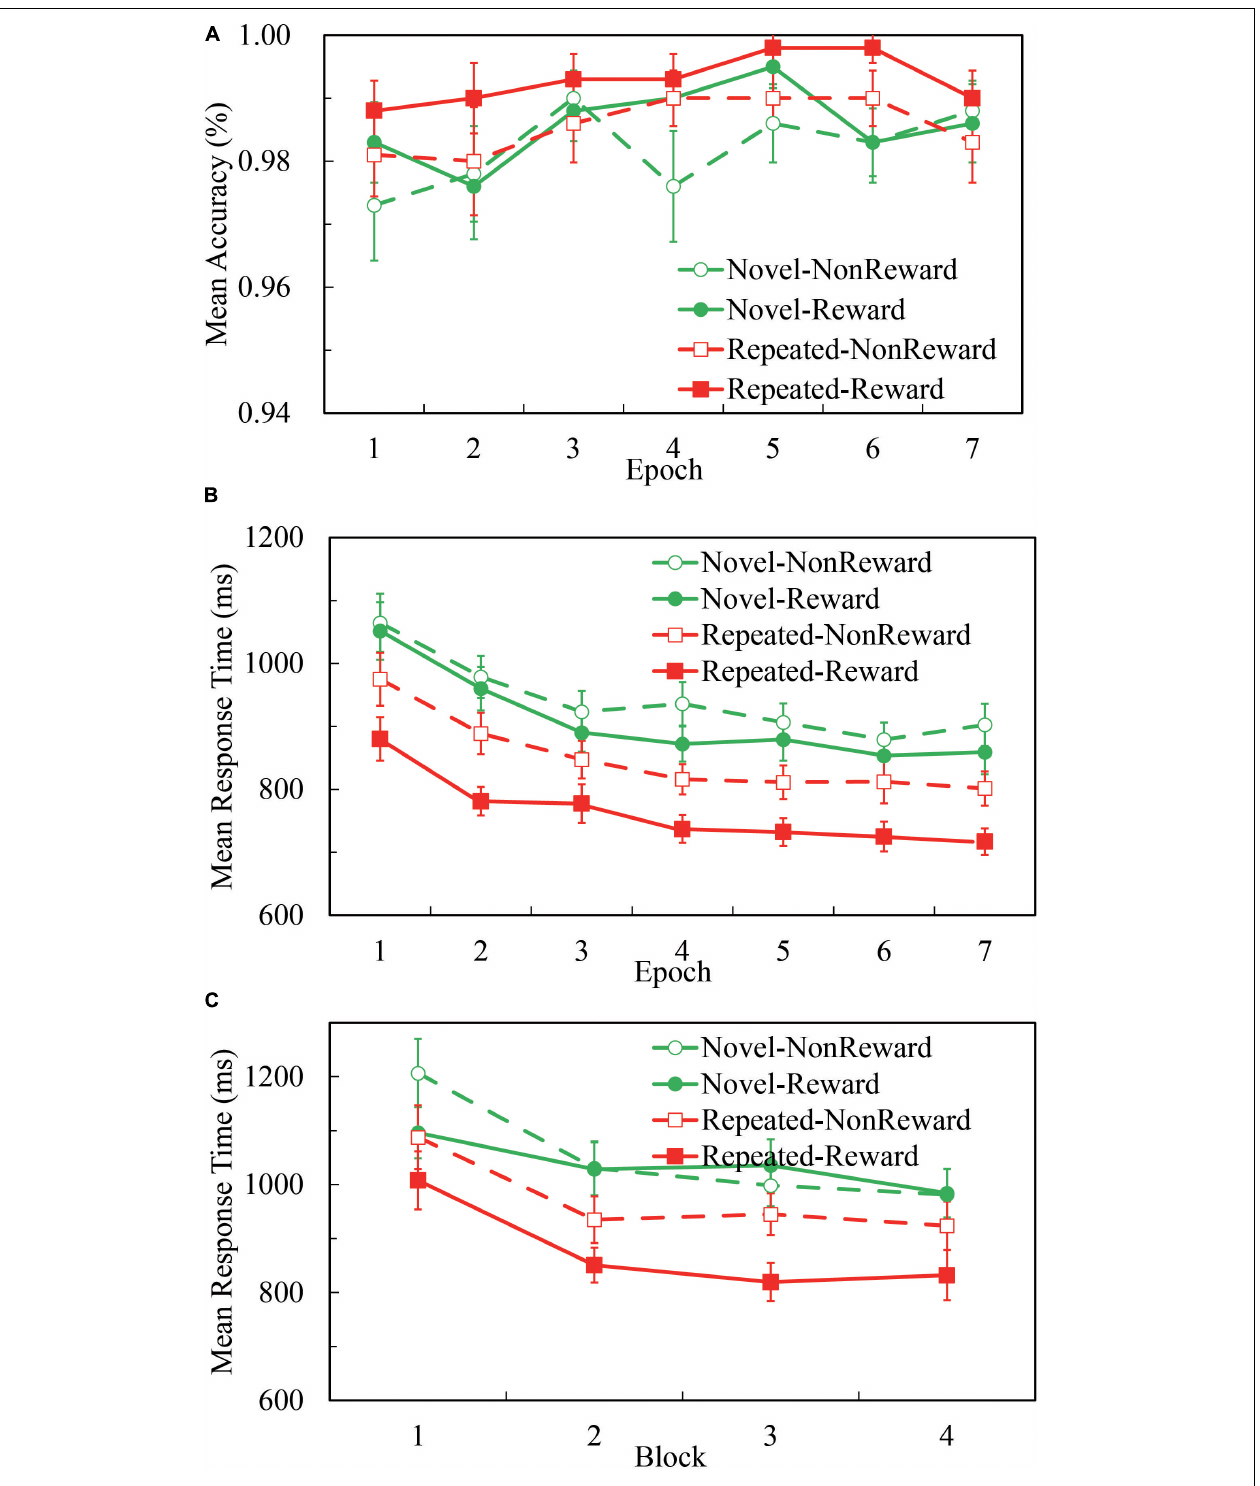
FIGURE 1 | Accuracies and response time (RT) performance in the Repeated-Reward, Repeated-Non-reward, Novel-Reward, and Novel-Non-reward conditions. (A) Mean accuracies as a function of epoch (seven epochs, separately averaged in four blocks). Error bars represent the standard error of the mean. (B) Mean correct RTs plotted as a function of epoch. Error bars represent the standard error of the mean. (C) Mean correct RTs as a function of the block in the first epoch. Error bars represent the standard error of the mean.